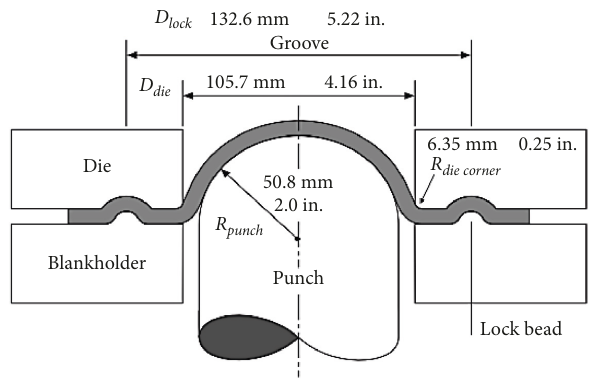
Figure 2: LDH experiment tooling